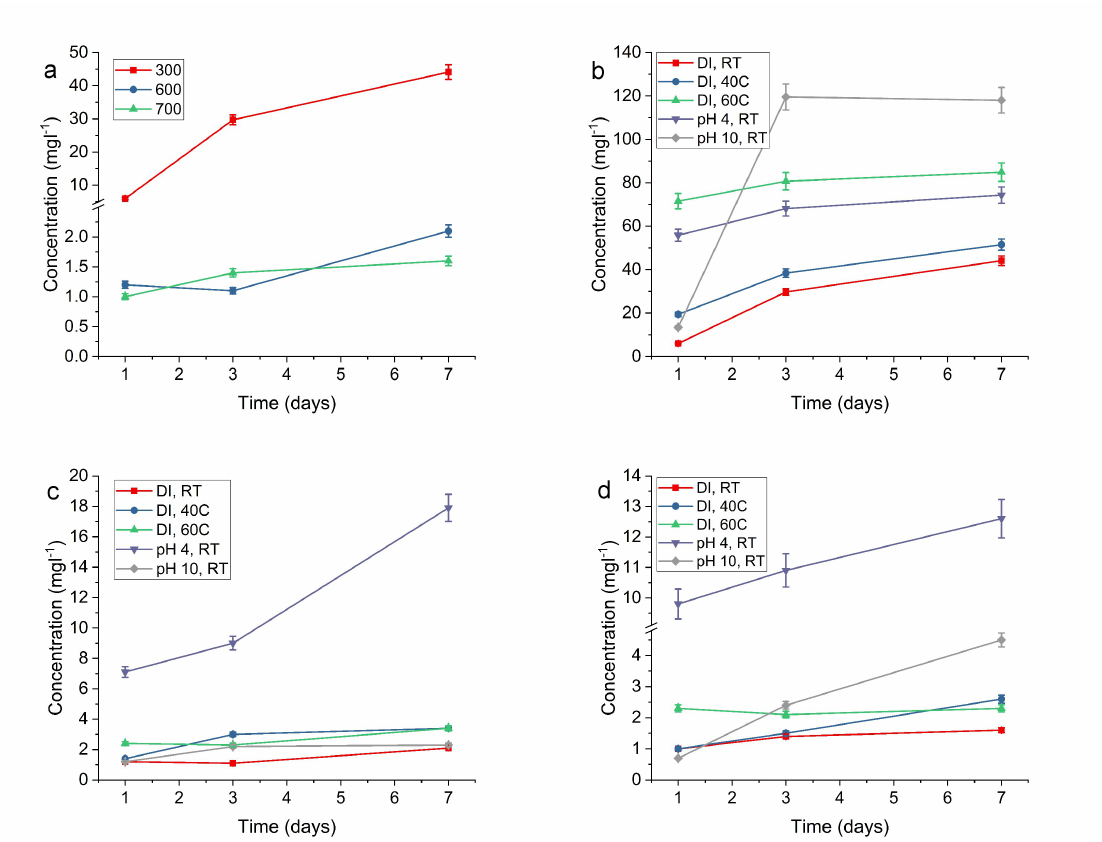
Figure 8. The release of silver from ( a ) SiO 2 -Ag 300, SiO 2 -Ag 600 and SiO 2 -Ag 700 during one to seven days in de-ionized water at room temperature. Comparison of Ag release at room temperature, 40 ◦ C, 60 ◦ C, pH 4, and pH 10 for ( b ) SiO 2 -Ag 300; ( c ) SiO 2 -Ag 600; and ( d ) SiO 2 -Ag 700. The time scale is in days. In the legend: DI is de-ionized water, RT is room